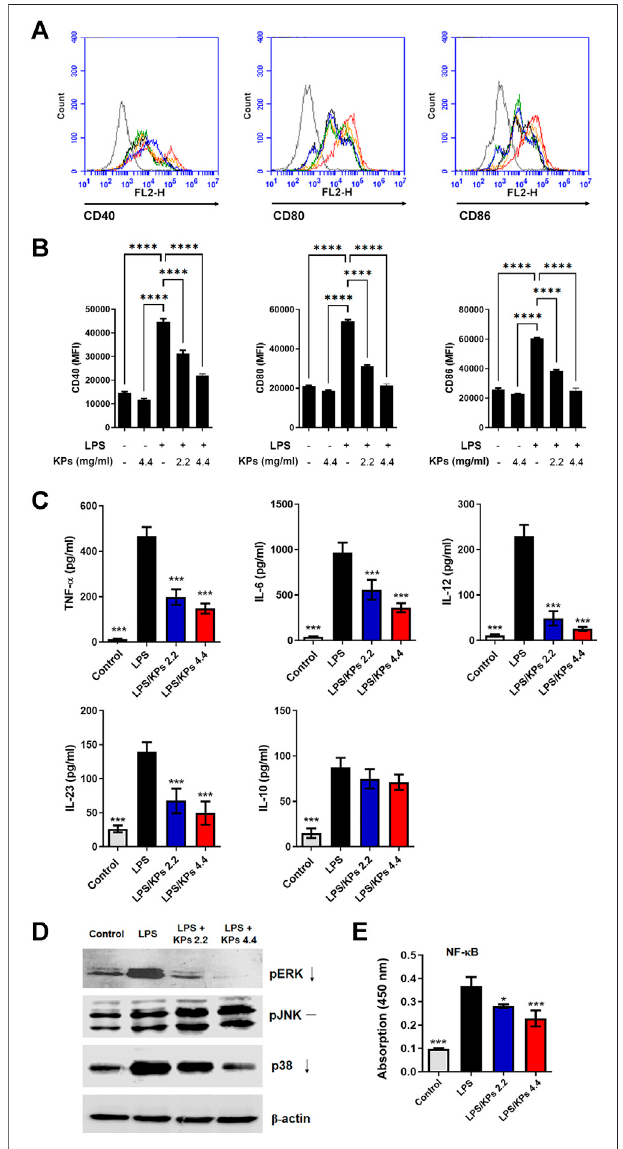
FIGURE 1 | Effect of KPs on the expression of immunomodulatory cell surface markers, the cytokine release, MAPK phosphorylation and NF- κ B translocation in LPS-treated mouse BMDCs. Immature murine BMDCs were stimulated with LPS (100 ng/ml) in the presence or absence of KPs (2.2 mg/ml and 4.4 mg/ml) for 24 h. (A) Representative histogram graphs of the mean fl uorescence intensity (MFI) of costimulatory molecules CD40, CD80 and CD86onCD11c + DCcellsexaminedby fl owcytometry. (B) MFIvaluespresented asthe mean ± SEMfrom three independent experiments(n (cid:1) 3). **** p < 0.0001, as determined by one-way ANOVA test. (C) Cell-free supernatants were collected, and cytokine production was measured by ELISA. The concentrations arepresentedasthemean ± SEM(n (cid:1) 3). (D) ImmatureBMDCswerestimulated withLPS(100 ng/ml)withorwithoutKPs(2.2 mg/mland4.4 mg/ml)andlysedat 6 h after treatment.The levels of phosphorylated pERK, pJNKand p38 MAPK in wholecelllysateswereanalyzedbyWesternblotting.Representativeimagesfrom one of three independent experiments are shown. (E) The concentration of NF- κ B/p65in nuclearextractswasmeasured usinga Trans AM assay. The valuesare presented as the mean ± SEM (n (cid:1) 3). * p < 0.05; *** p < 0.001 vs the LPS alone control group, as determined by one-way ANOVA with Dunnett ’ s